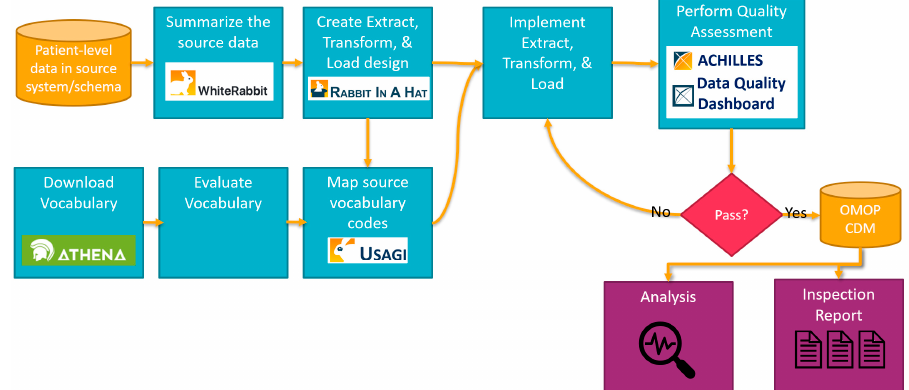
Figure 1. The Data Conversion to Analysis Pipeline to the Observational Medical Outcomes Partnership Common Data Model (OMOP CDM) used by the European Health Data and Evidence Network (EHDEN).